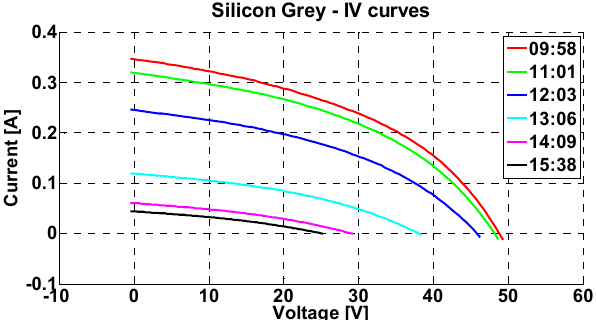
Figure 20. Grey silicon cell current-voltage curves for different irradiance values.